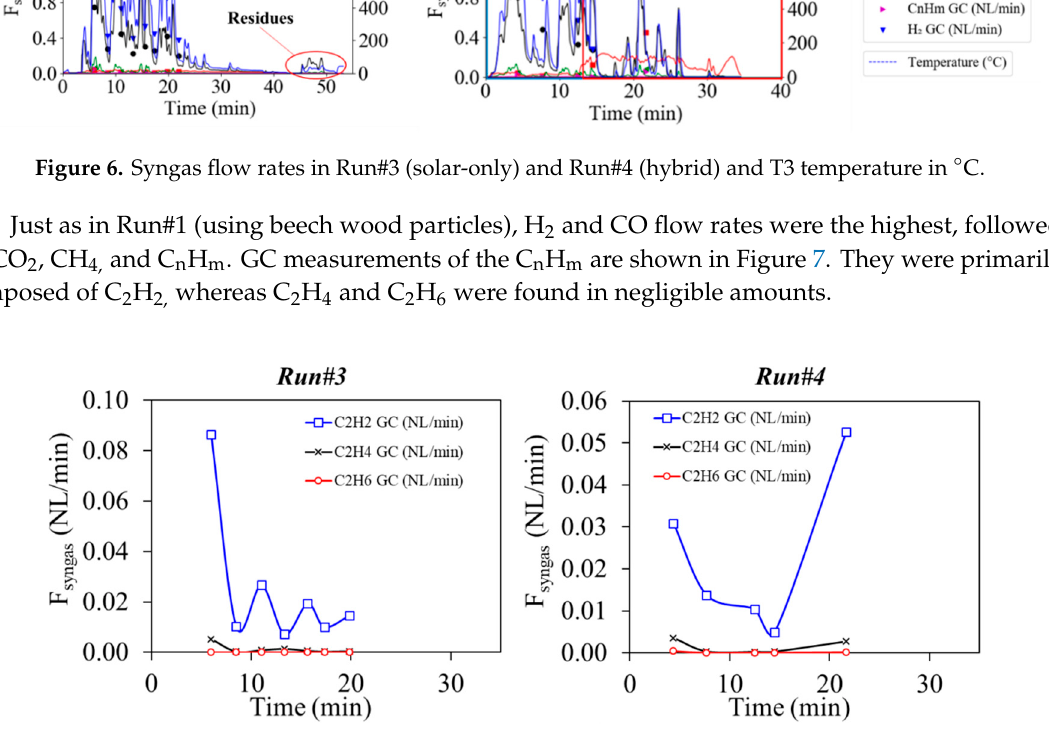
Figure 7. GC analysis of C n H m during Runs#3,4.